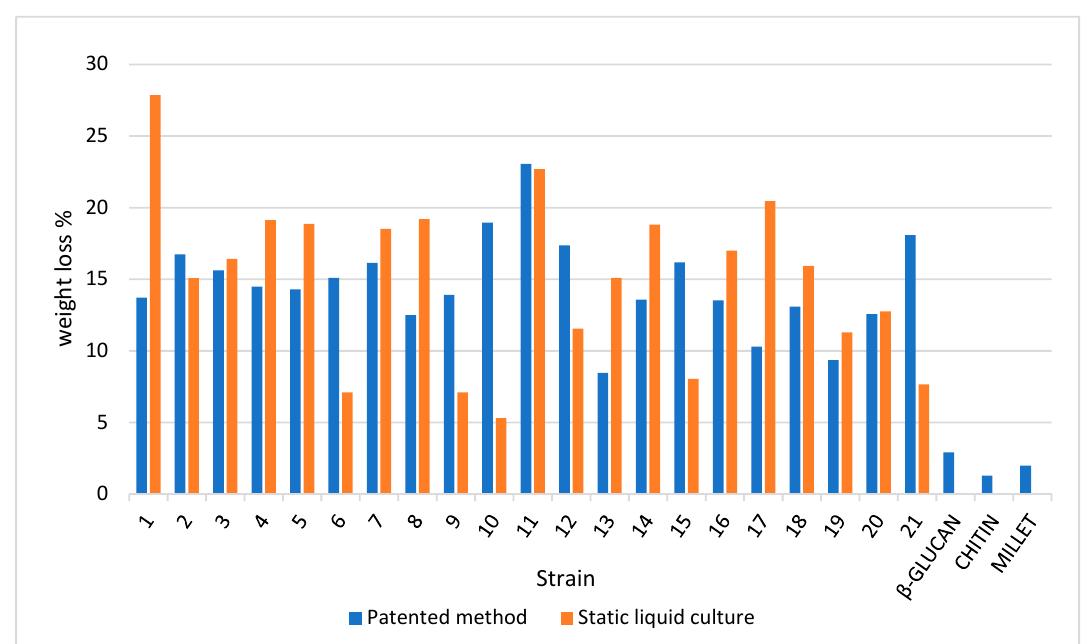
Figure 6. Weight loss percentage for the dry samples in the 125–250 °C temperature range (TGA output) in the mycelium (pure mycelium and slurry mat) and reference materials.